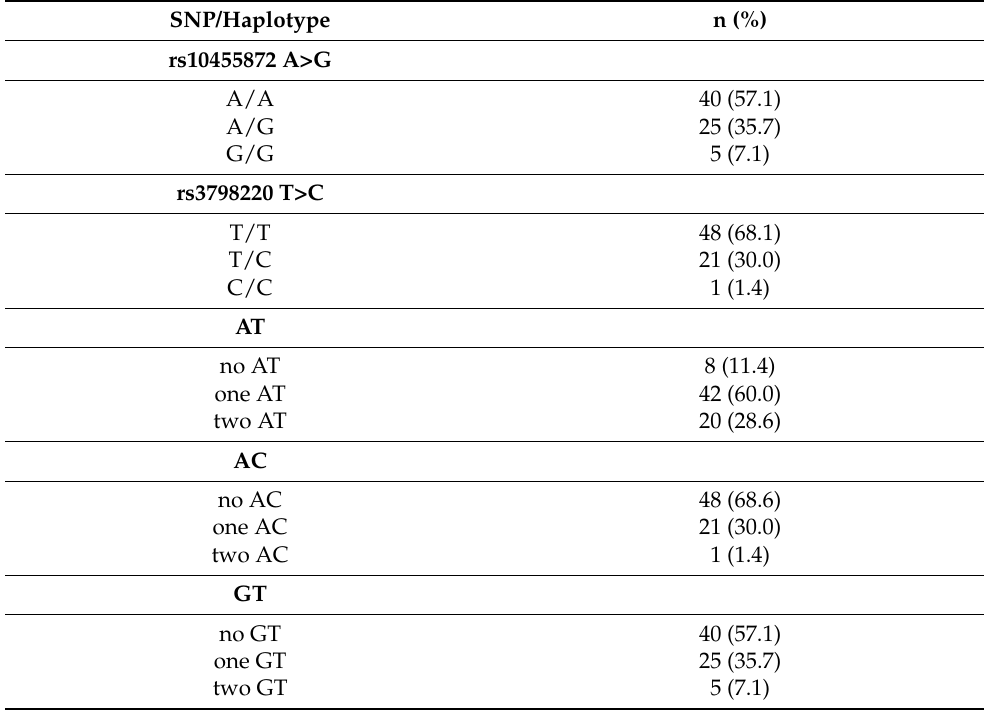
Table 2. Genotype/haplotype frequency